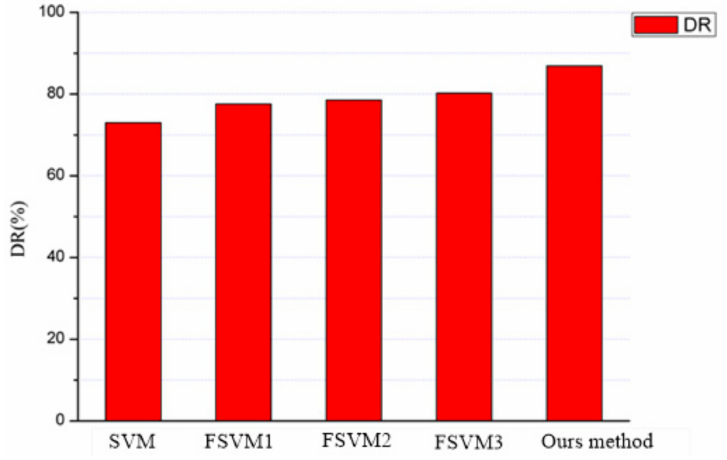
Figure 7. Performance comparisons on UNM_live_lpr data